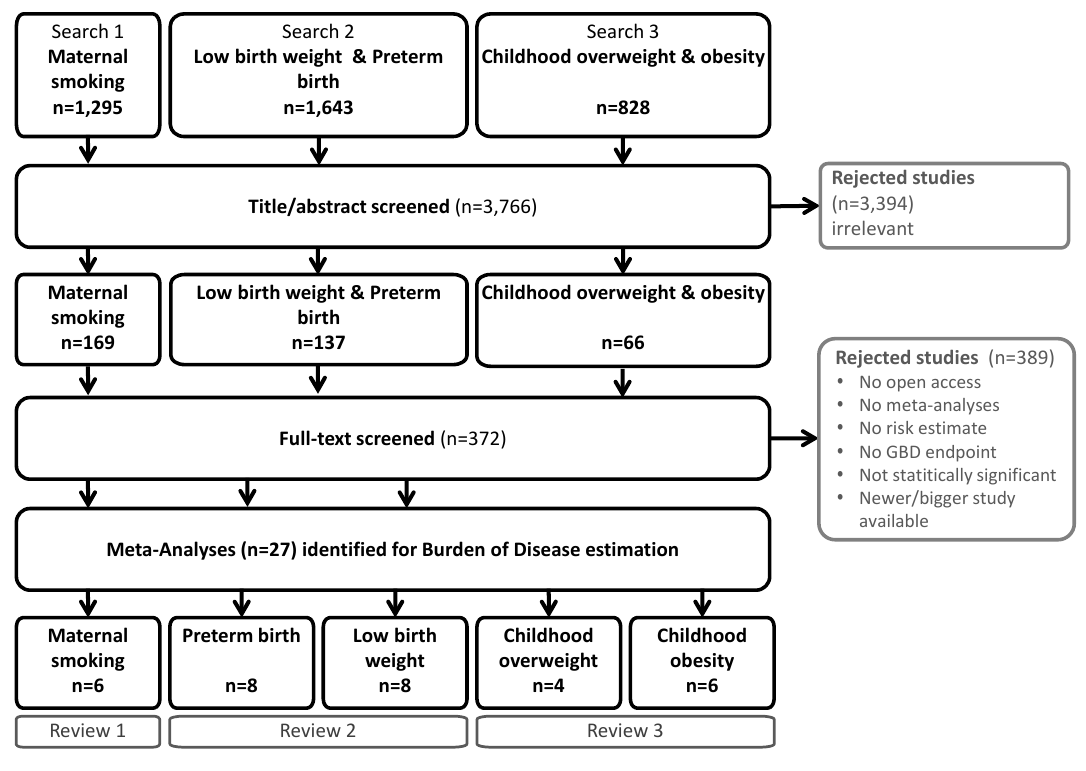
Figure 3. Systematic umbrella literature searches processes for reviews 1 −3 .